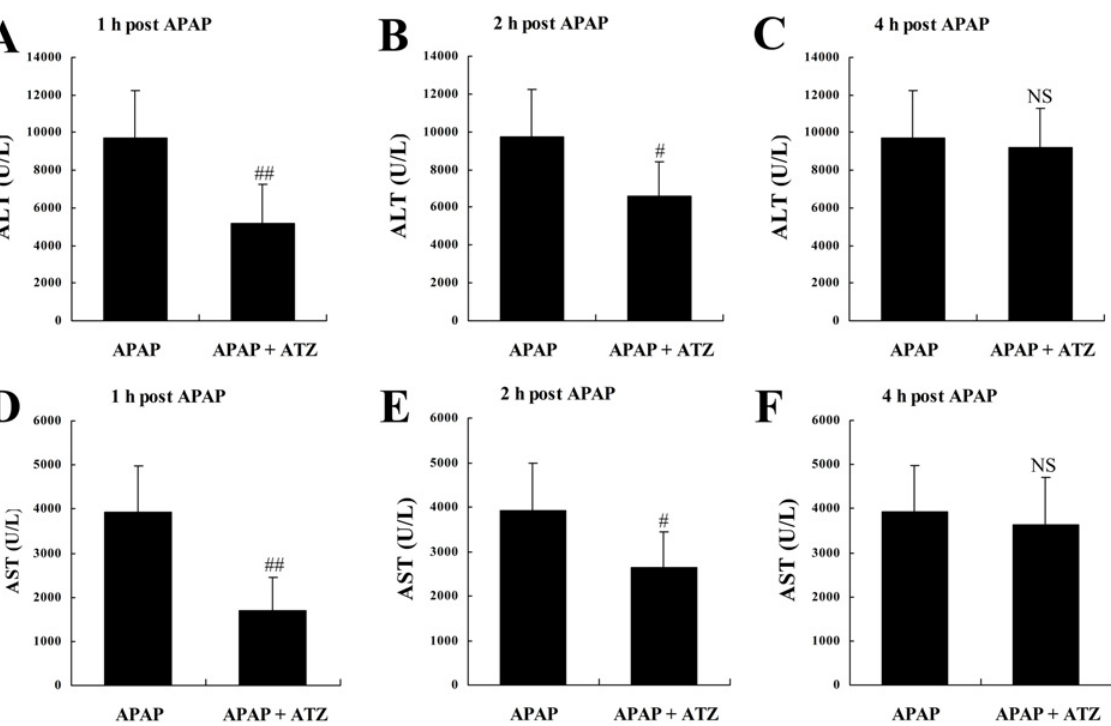
Fig 8. Posttreatment with ATZ suppressed the elevation of plasma aminotransferases induced by APAP. Mice were treated with vehicle or ATZ (500 mg/kg) at 1 h (A and D), 2 h (B and E) or 4 h (C and F) after APAP exposure. The plasma levels of alanine aminotransferase (ALT, A-C) and aspartate aminotransferase (AST, D-F) were determined at 8 h after LPS/D-Gal exposure. Data were expressed as mean ± SD, n = 8. NS P > 0.05, # P < 0.05, ## P < 0.01, as compared with the APAP